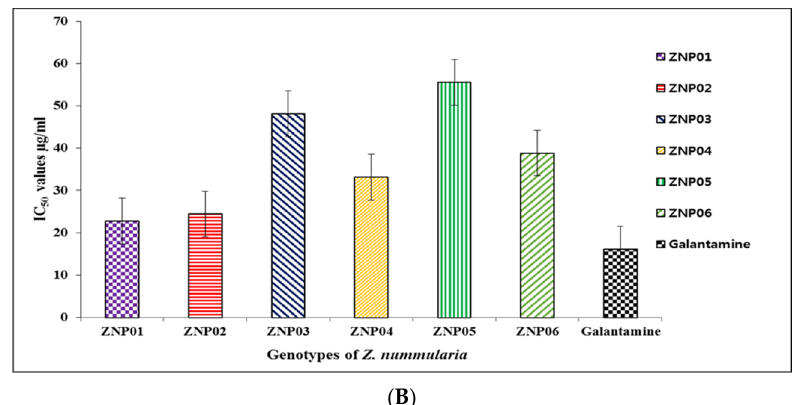
Figure 2. IC 50 values of different genotypes of Z. nummularia of AChE ( A ) and BChE ( B ) inhibitory activities.